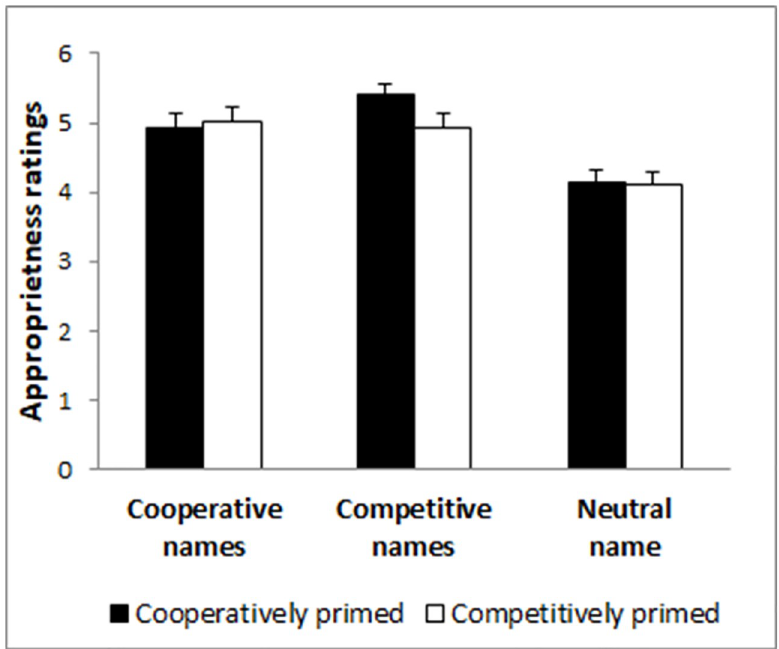
Fig 1. Mean appropriateness ratings for the competitive, cooperative, and neutral names as a function of experimental